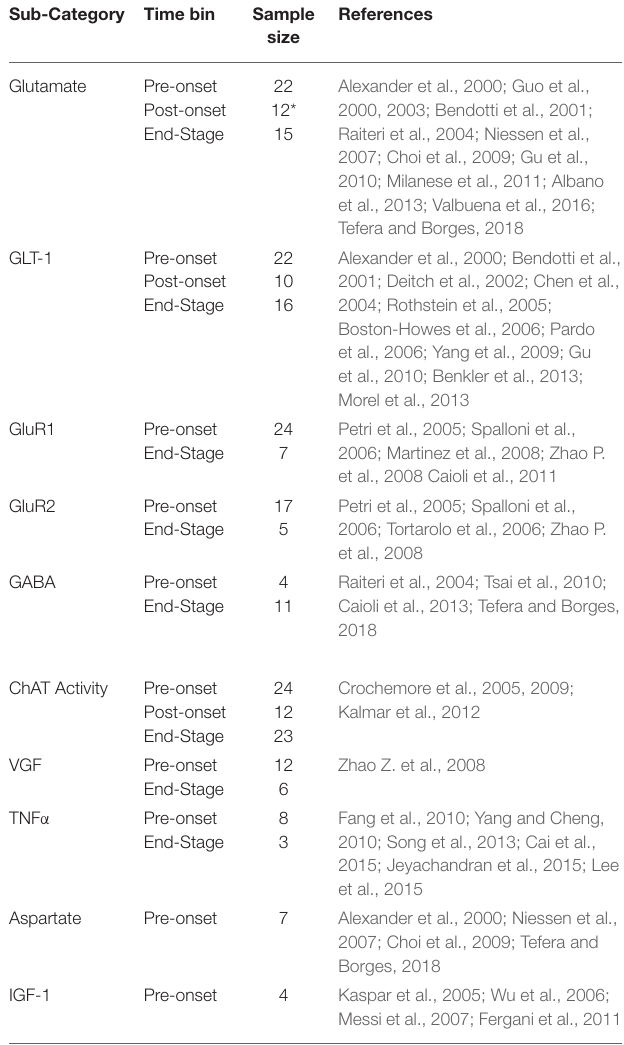
TABLE 2 | Number of data points used in each